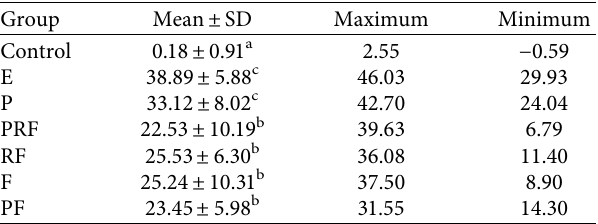
Table 2: Measures of central dispersion for change in micro- hardness of the groups.